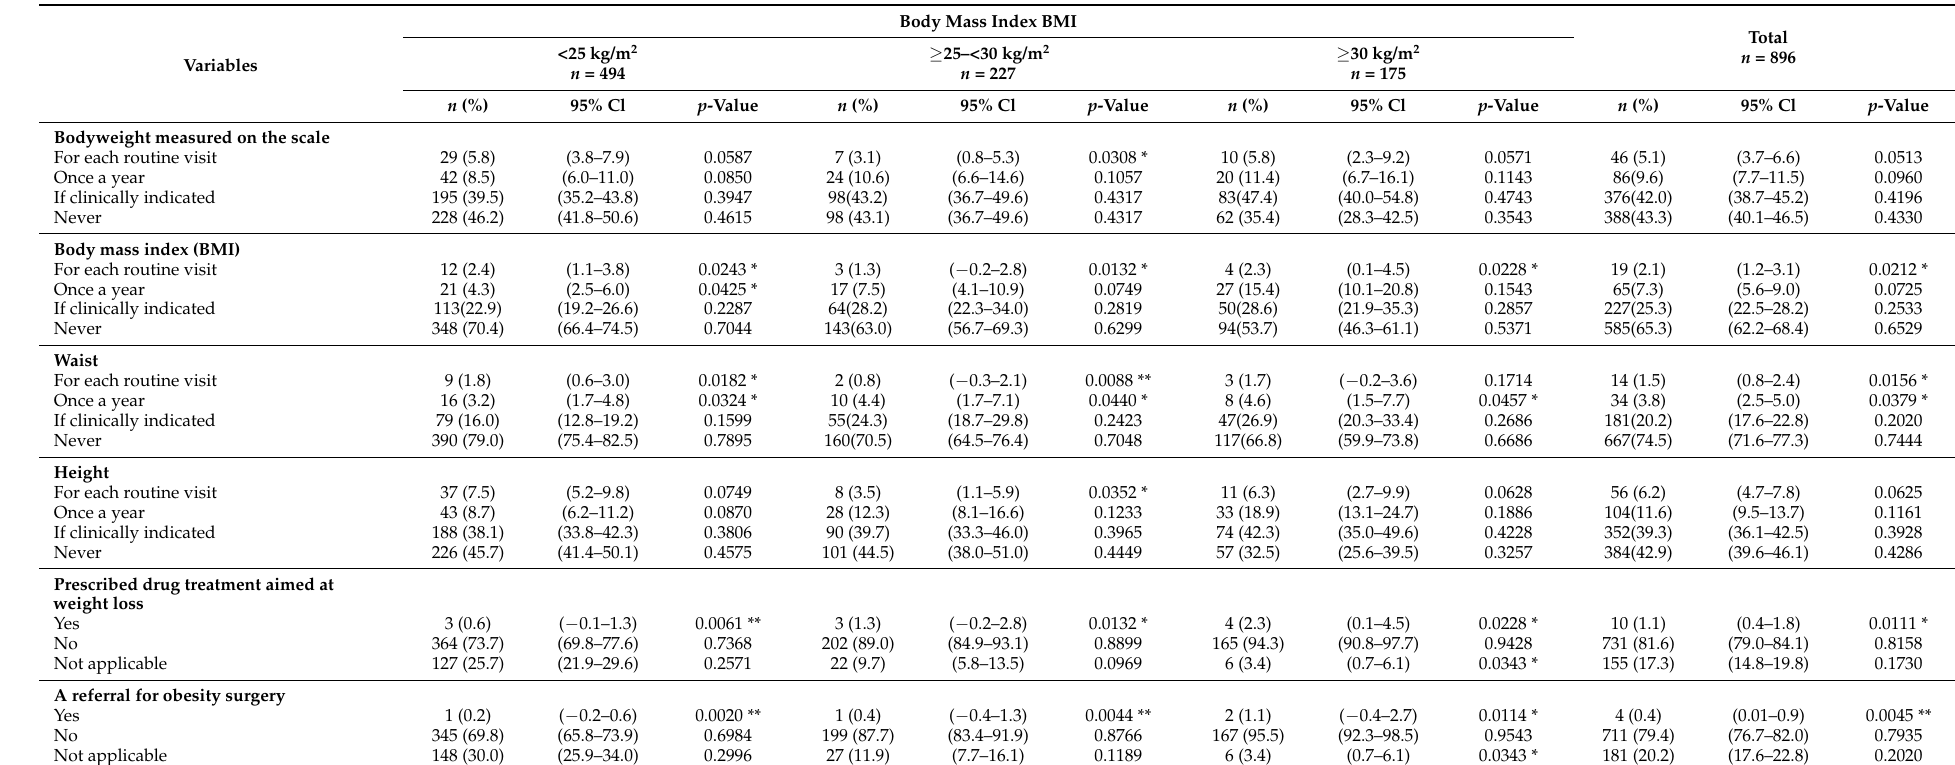
Table 4. Frequency of measurement of body weight and other variables by a GP in primary care